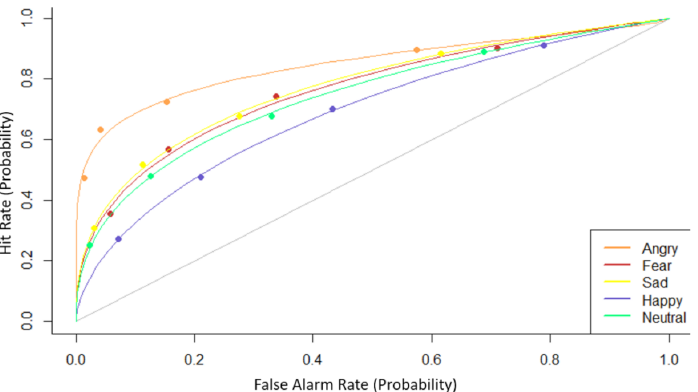
Figure 1. ROC curves for recognition of emotional facial expressions. Participants recognize angry faces best and the recognition for angry faces deviated the most from the recognition of neutral face